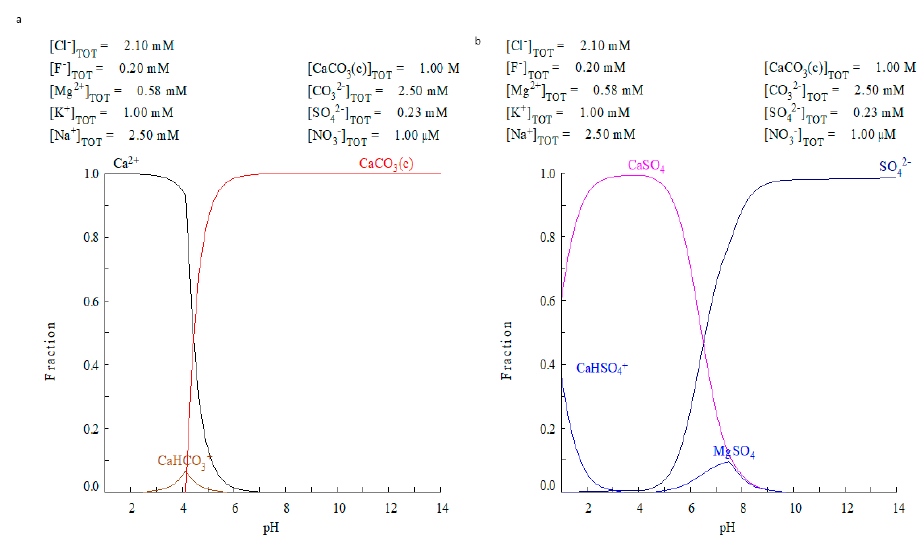
Figure 8. Medusa-Hydra output for rainwater (T 1 ) interaction with calcium carbonate. ( a ) Calcium species distribution vs. pH and ( b ) sulphate species vs. pH. In neither case is the observed salt formation explained.